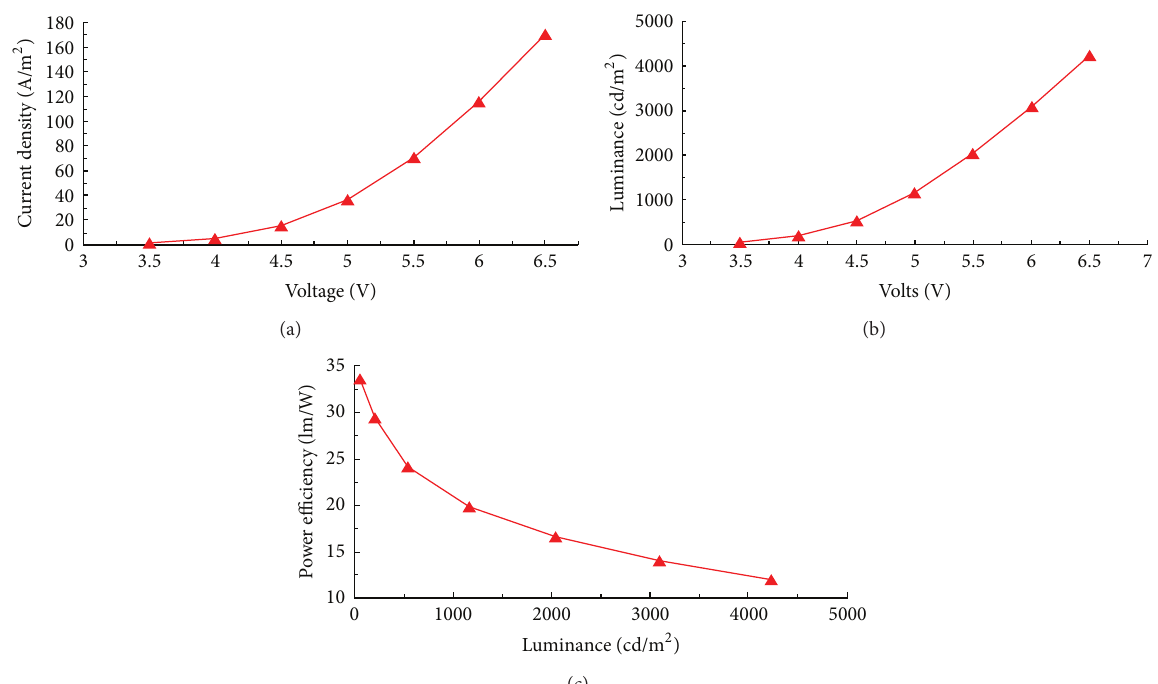
Figure 9: (a) The current density-voltage characteristic. (b) The brightness-voltage characteristic. (c) The power efficiency versus luminance of the OLED device.